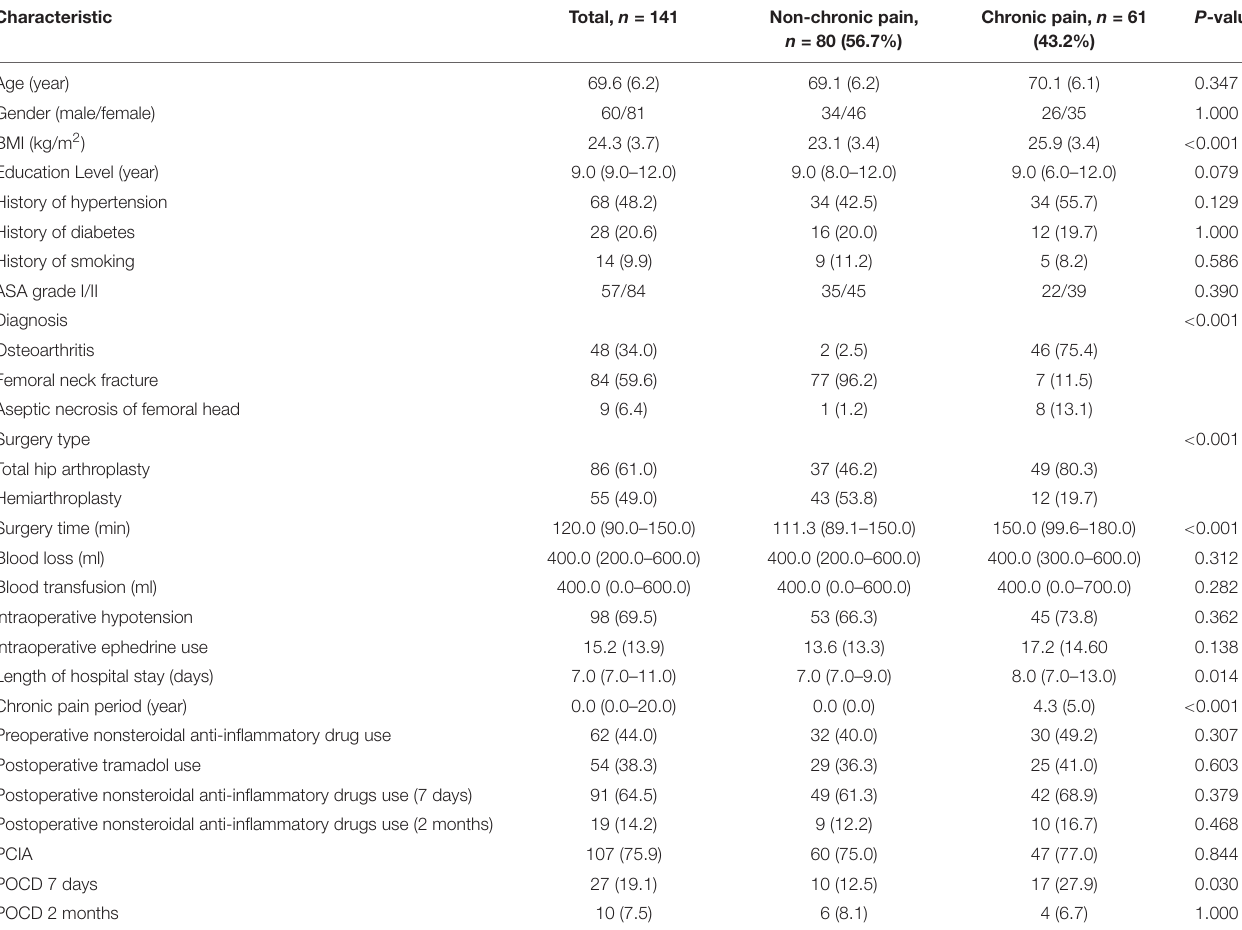
TABLE 1 | General characteristics of